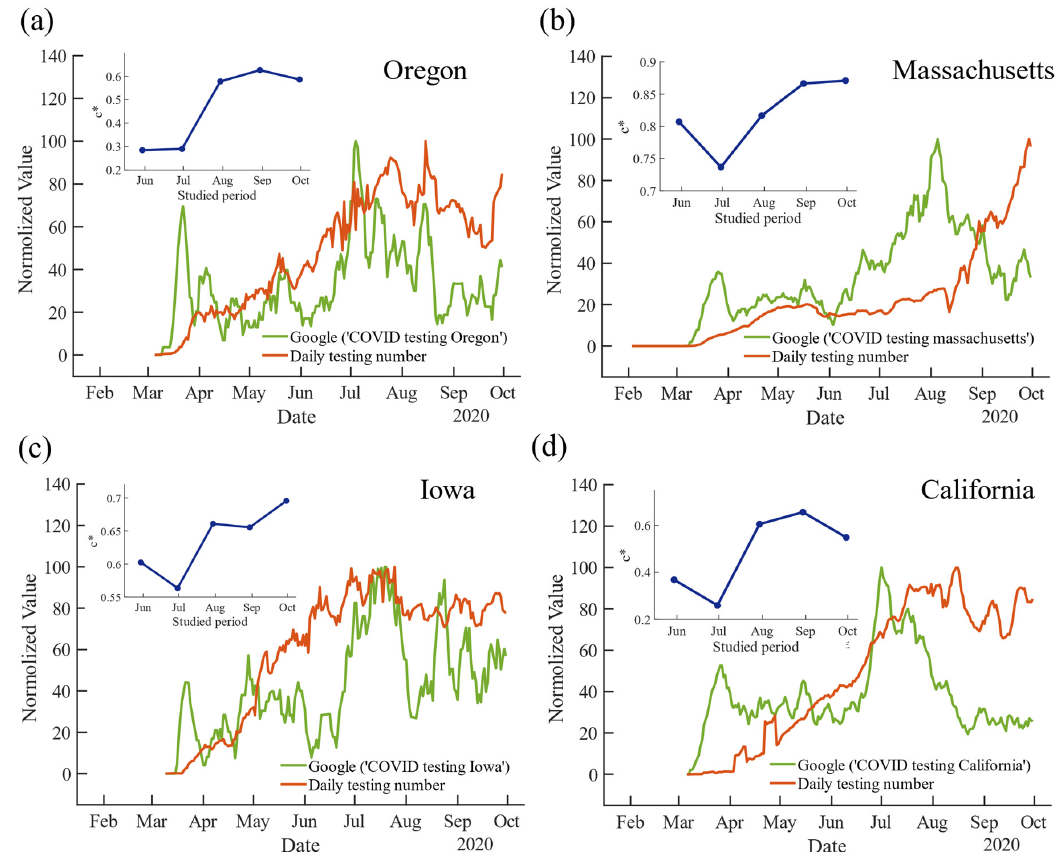
Figure 5. Google Trends index using the keyword ‘COVID testing’ (combined with a state’s full name) and daily testing number till 30 September 2020. The values of each curve are first smoothed by a 7-day-average to reduce the noise and are then normalized to [0, 100] for comparison. The inset in each chart lists the value of the highest correlation strength 𝑐 ∗ vs. the studied period for the COVID-19 daily testing number and the Google index using ‘COVID testing + state.’